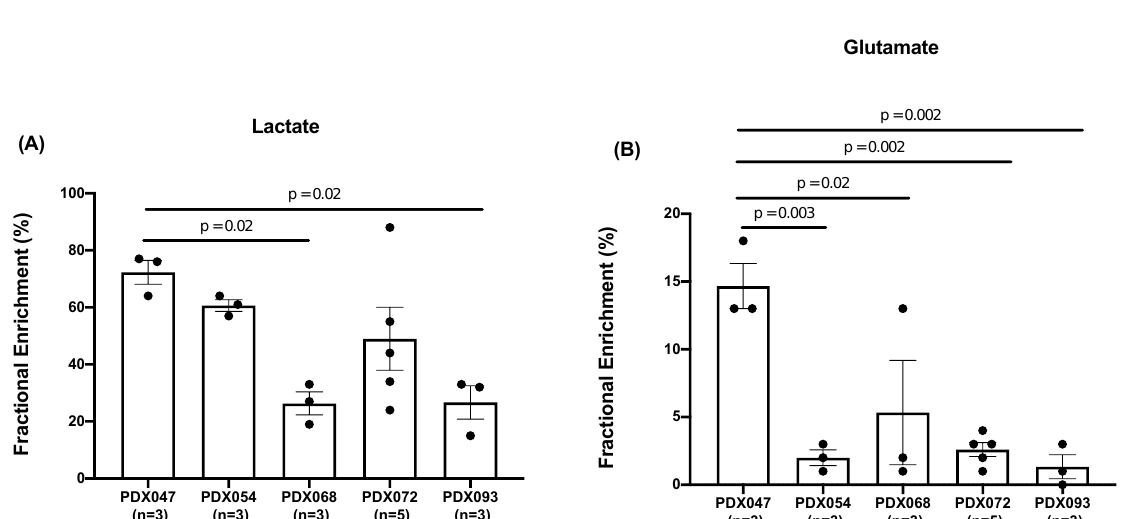
13 C isotopomer data using tcaCALC software to determine if there was any anaplerotic flux of carbons into the TCA cycle and found that the pyruvate carboxylase (PC) pathway contributed to the carbons of the TCA cycle equivalently to pyruvate dehydrogenase (PDH) (Supplementary Figure S11). Comparing different passages of PDX047, FE of both lactate and glutamate was higher in P3 than in P4 (Supplementary Figure S12). Further, comparison of lactate and glutamate FE between the PDX and their corresponding XEN showed that lactate FE was significantly higher in PDX047 compared to XEN047, but lower in PDX093 compared to XEN093, and equivalent between PDX/XEN054 and PDX/XEN072 (Figure 9A – D). Glutamate FE was similar between all PDX and XEN pairs